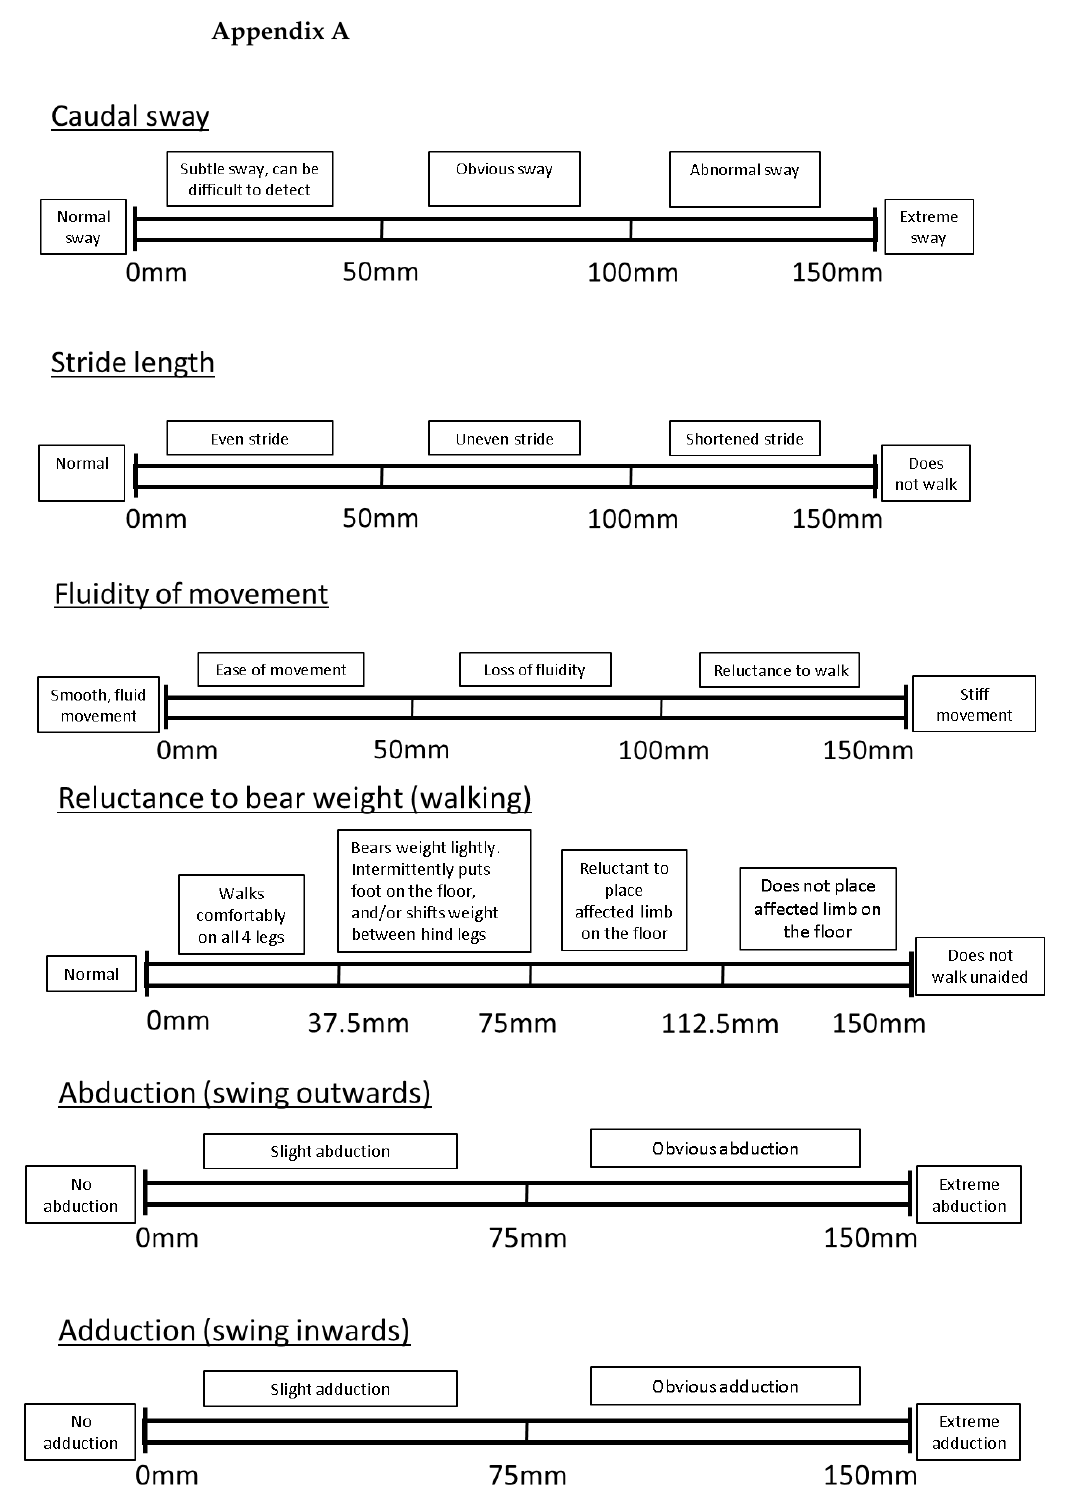
Figure A1. Individual visual analogue scale locomotion components, with descriptive sublevels based on pig locomotion assessment literature, to aid with consistency of scoring.